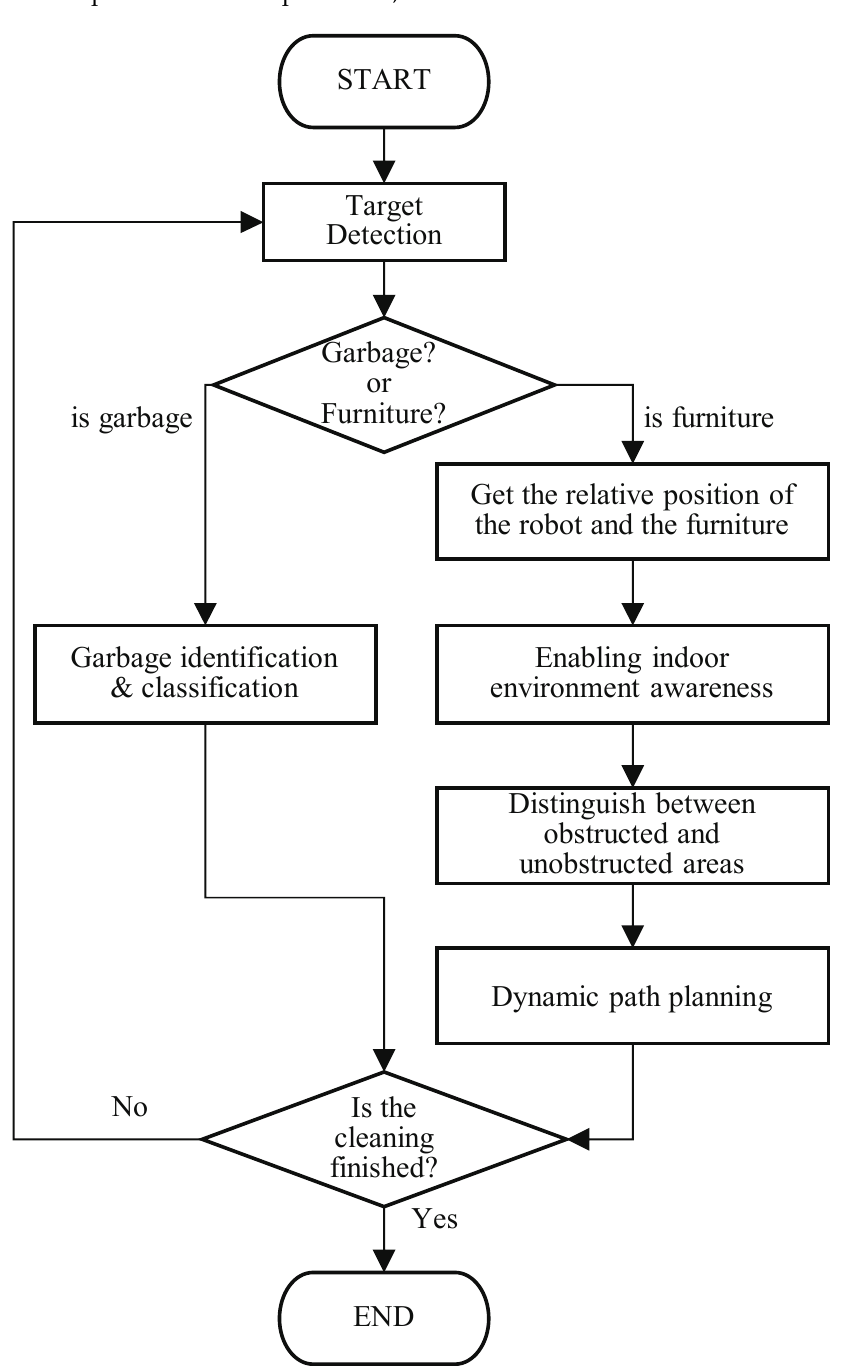
Figure 3. Autonomous visual navigation method for sweeping robot based on superpixel